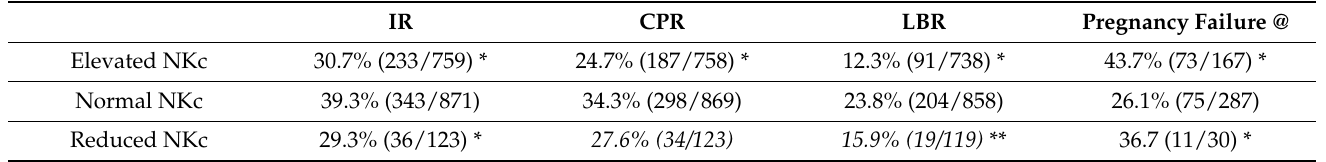
Table 3. Success rates of IVF cycles in patients with different NKc status.